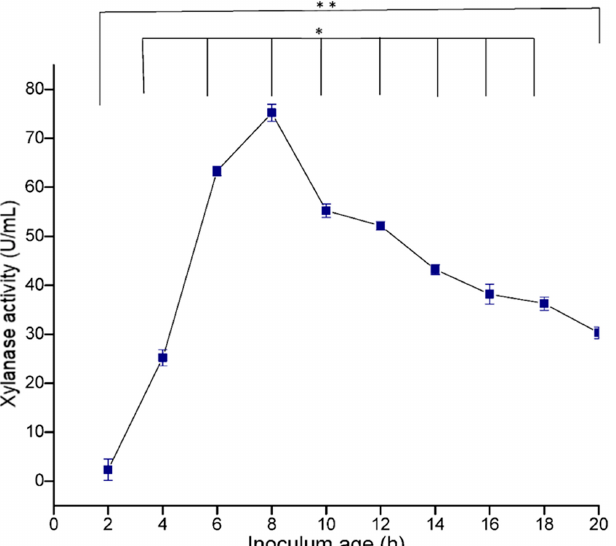
Figure 9. Optimization of inoculum age for the production of xylanase by B. safensis XPS7. (Medium: M5; temp.: 45 °C; time: 24 h; pH: 9; inoculum: 4%). All the experiments were performed in triplicate. Line graph display mean ± SD and statistical analysis was performed using a one-way ANOVA with a Tukey post hoc test, with p < 0.05 ** and p < 0.01 *.